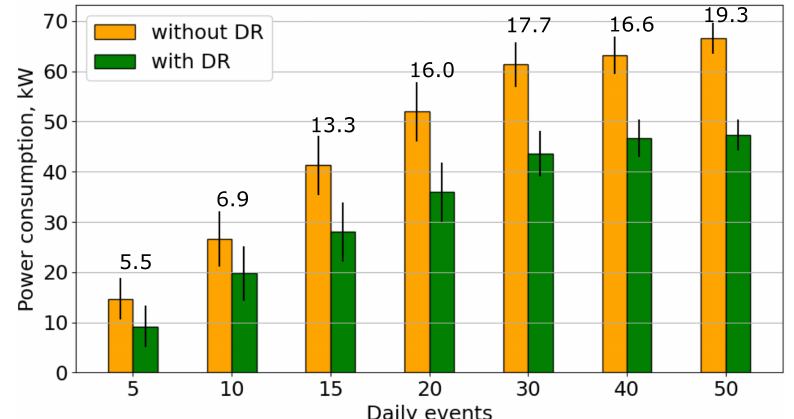
Figure 11. The effect of a DR event on the average value of power consumption during 10:00–11:00 for a building with 8 chargers of 11 kW each. DR event power reduction is 30% for 1 hour with 50 to 50% of time- and energy-based events, respectively. Black vertical bars indicate a 95% confidence interval of the mean value. The difference between bars mean values is presented on